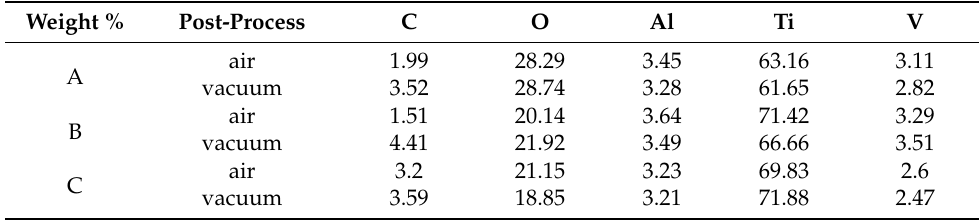
Table 8. Weight % of elements in the vacuum process sample and air stored samples.